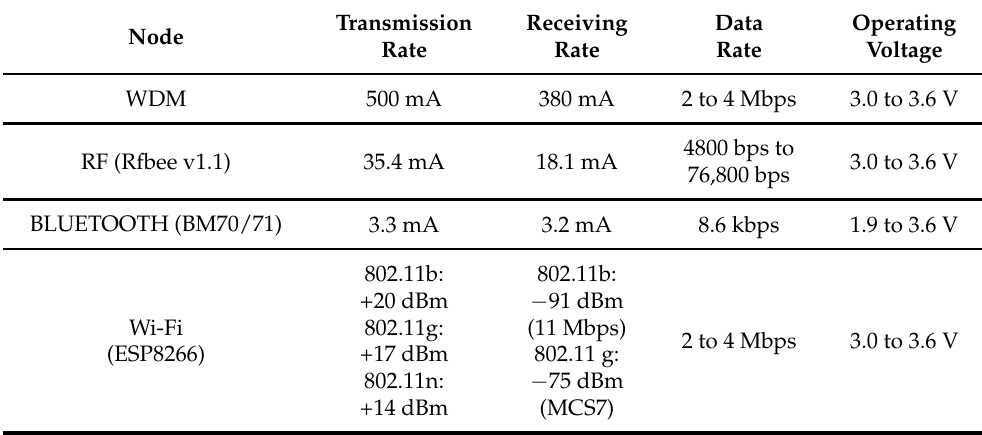
Transmission Receiving Data Operating Rate Rate Rate Voltage